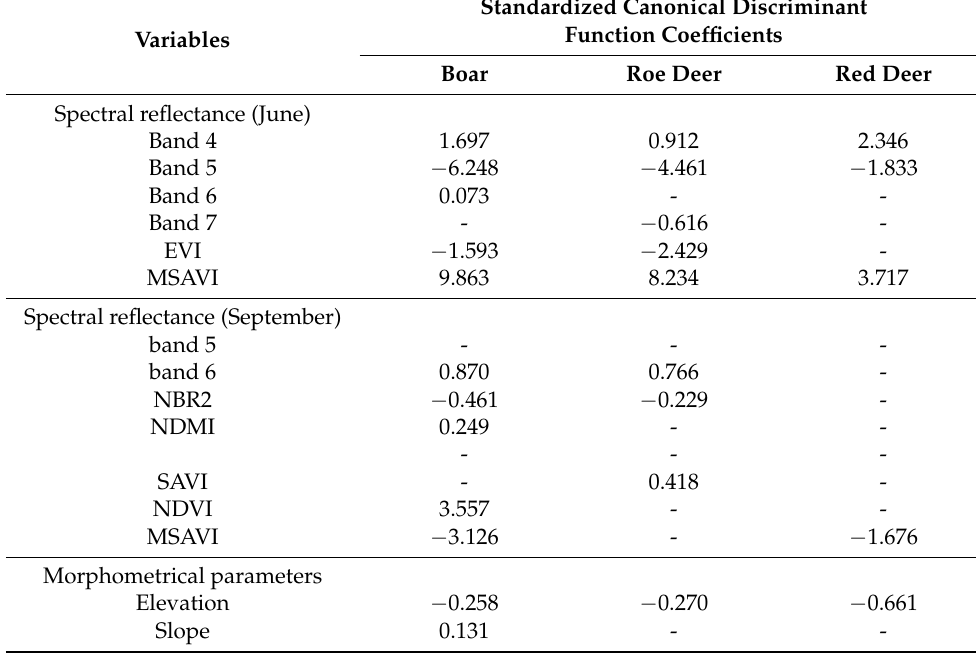
Table 7. Variables included in the discriminant